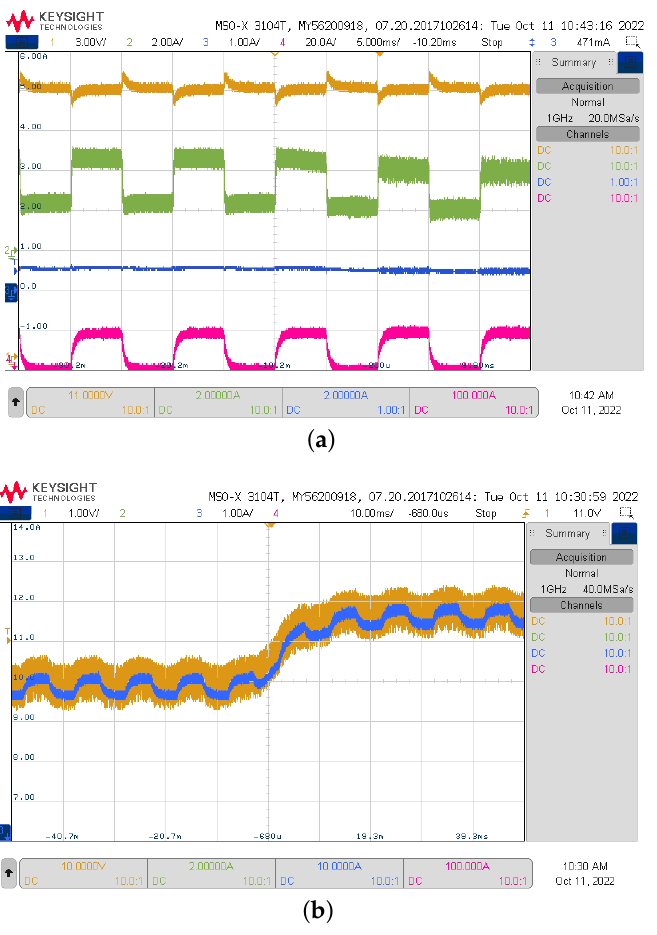
Figure 7. Dynamic response of the estimate ˆ E : ( a ) input voltage changes from 10 to 8 V. CH1: x 2 (3 V/div), CH2: x 1 (2 A/div), CH3: u (1/div), CH4: ˆ P (20 W/div), and time base of 5ms; ( b ) input voltage changes from 10 to 12 V. CH1: (1 V/div), CH2: (1 V/div), and time base of